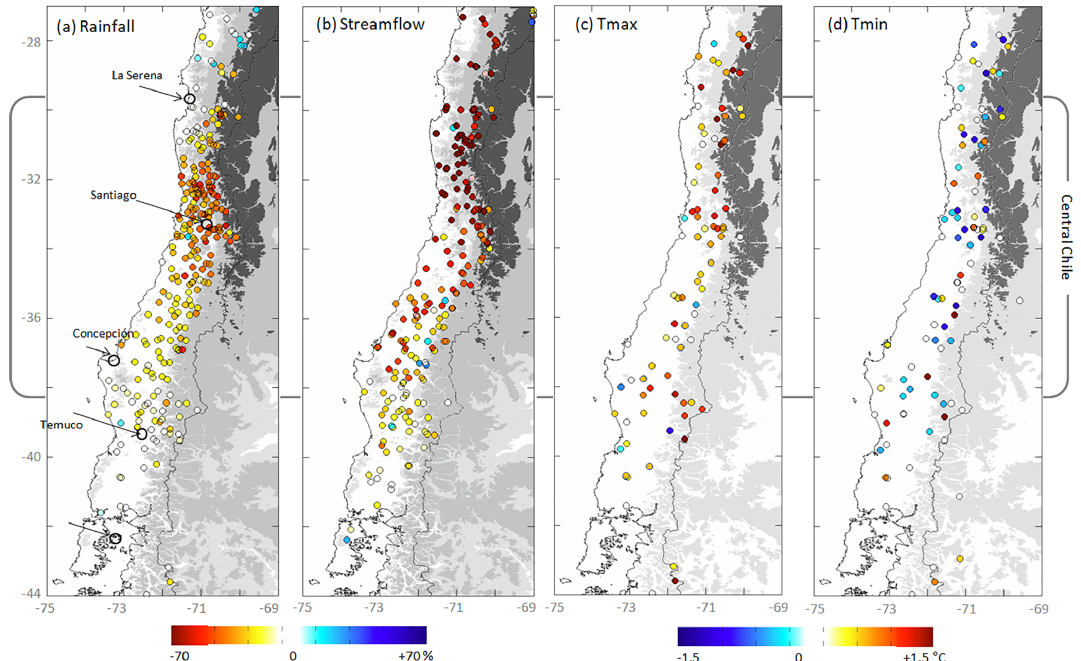
Figure 5. Station-based anomalies during the megadrought: (a) rainfall, (b) riverflow, (c) maximum temperature, and (d) minimum temper- ature. In all cases we first calculate the annual mean (accumulation for rainfall), then average the 2010–2015 period, and finally subtract the respective long-term mean (LTM; 1980–2010). Rainfall and riverflow MD anomalies expressed as a percentage of the LTM. Temperature anomalies are absolute values in ◦ C. Note the existence of some outliers (e.g., a warming station within a cooling region), probably due to problems in data